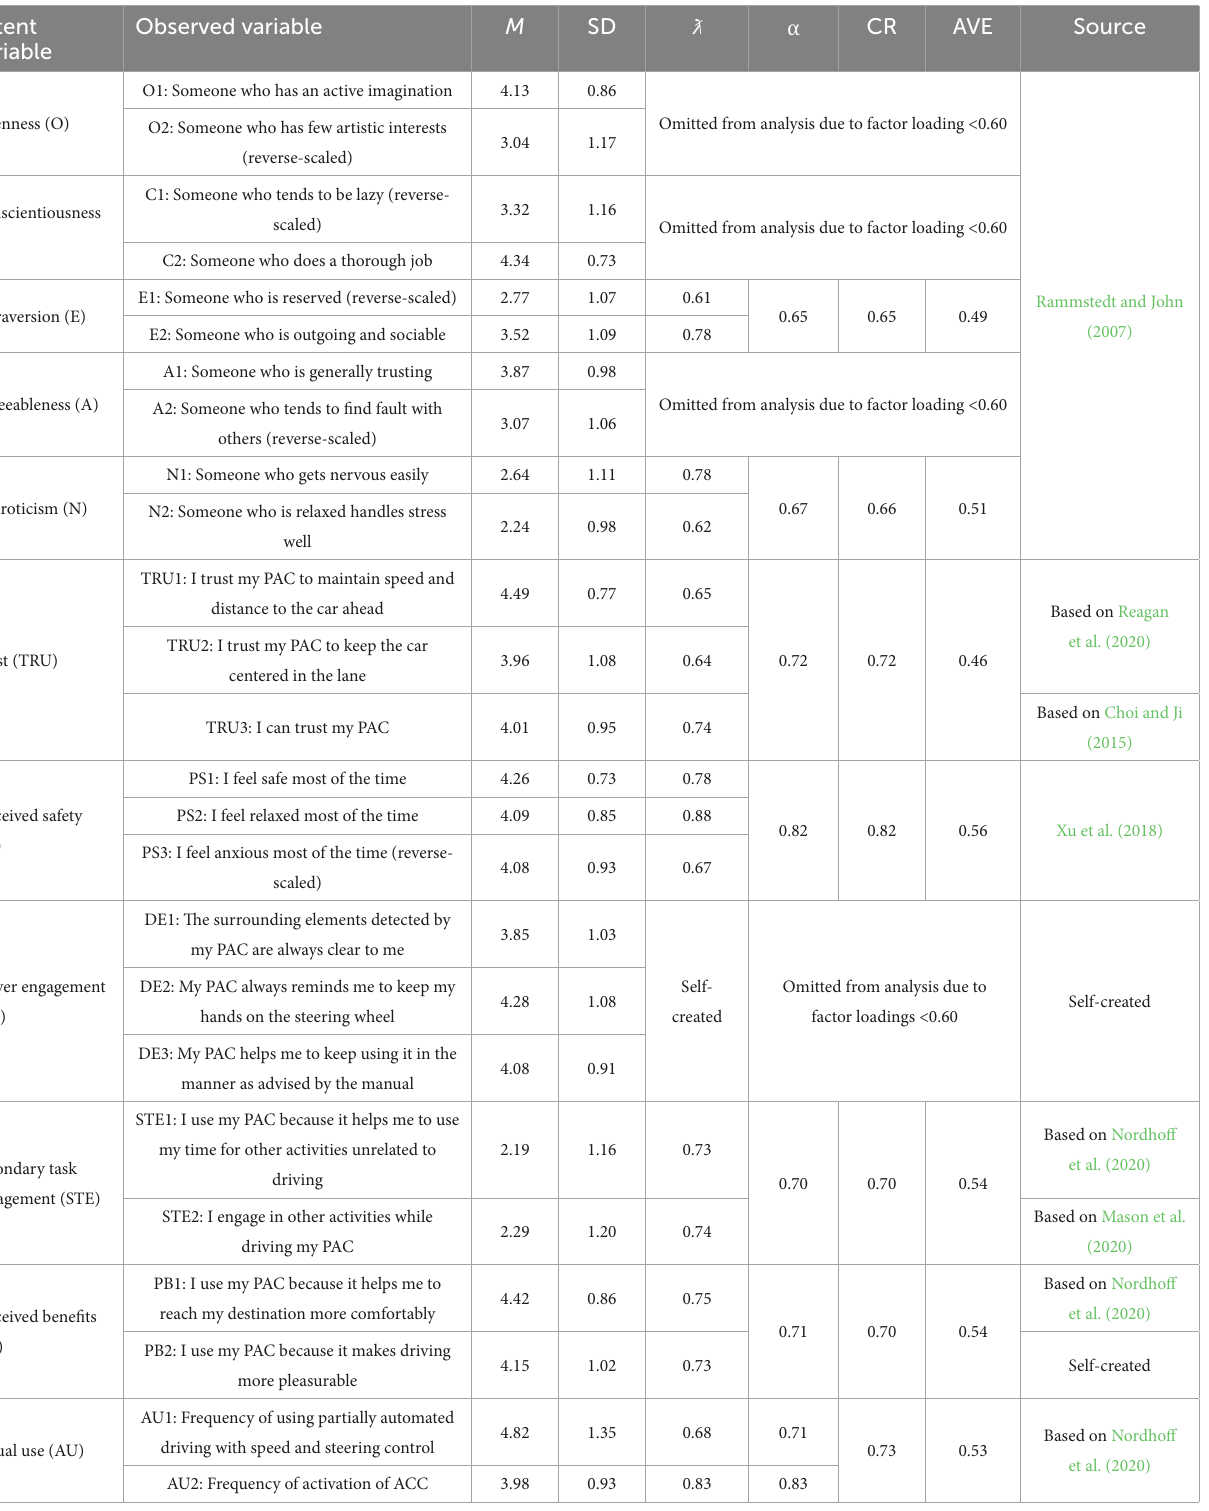
TABLE 4 Confirmatory factor analysis ( M , means, SD, standard deviation, ƛ , lambda, variance